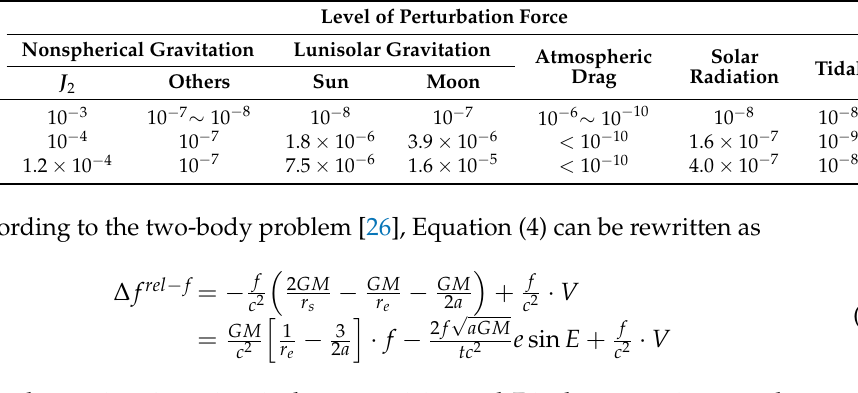
Table 2. Level of perturbation forces on satellites in different orbits